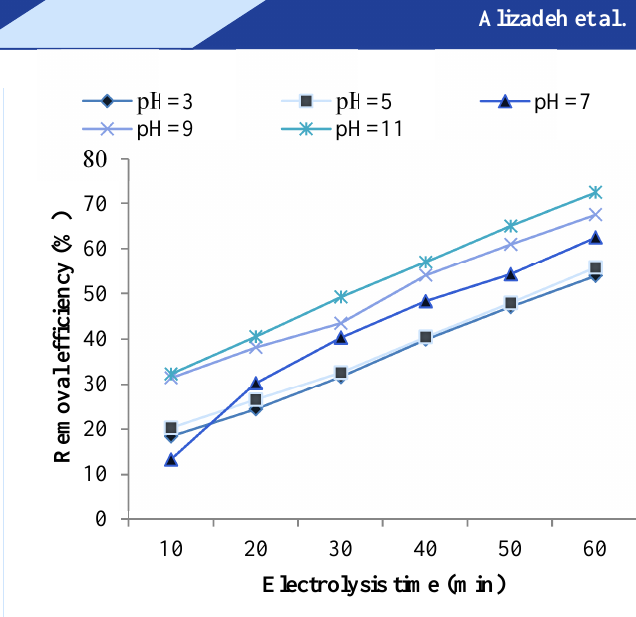
Figure 4. Effect of initial pH on removal efficiency of Reactive Green 19 (RG-19) dye